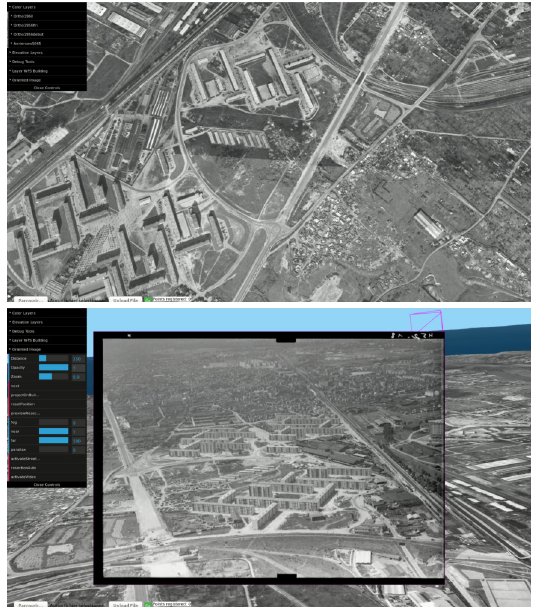
Figure 11. Navigation in the 3D environment: (top) Vertical view, with historical ortho-imagery, of the shantytowns next to a brand new housing complex; (bottom) another point of view, through historical geolocalized oblique